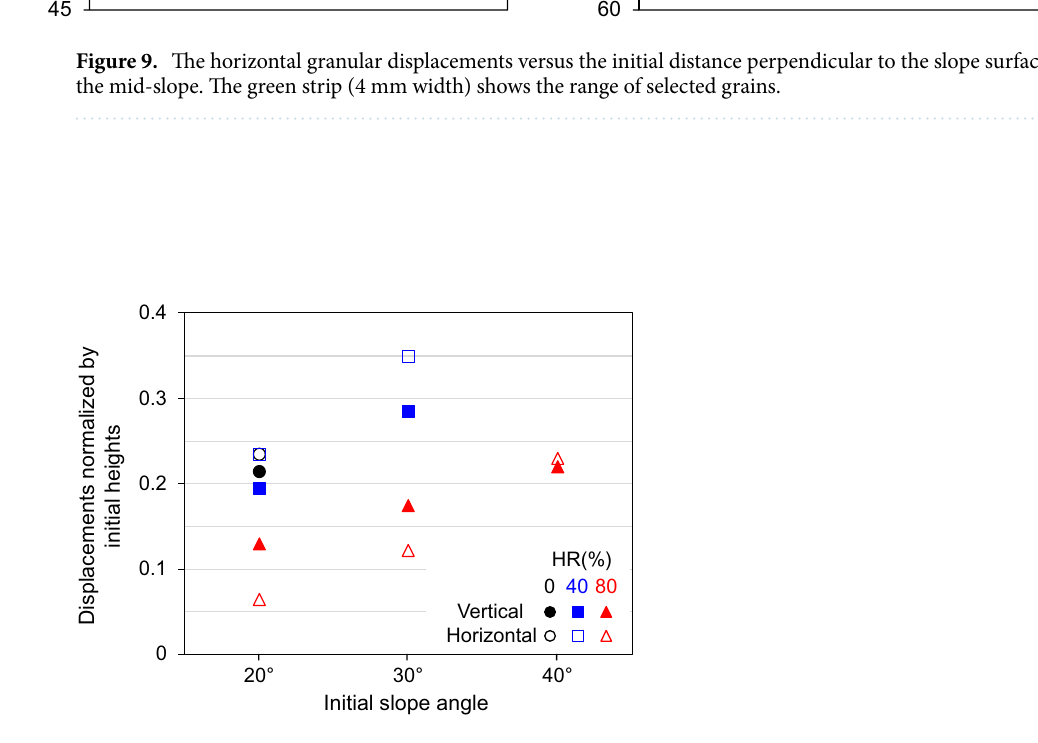
Figure 10. Vertical and horizontal granular displacements at the top of the selection (see Fig. 9) normalized by the initial heights from the base. Numerical data from Table 2 (the 4th and 5th